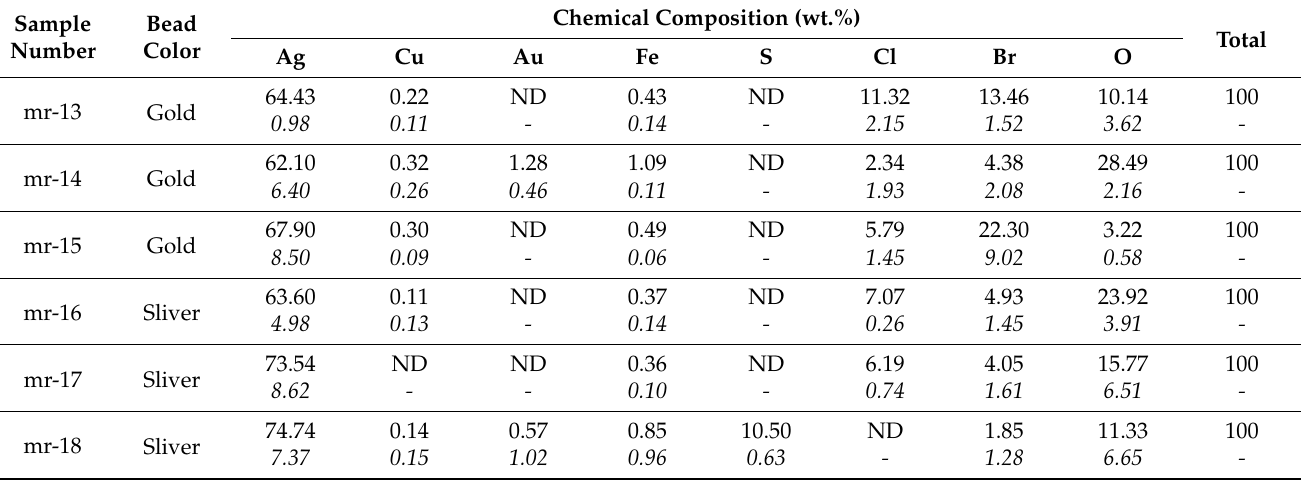
Table 2. SEM-EDS analytical results of metal foil in foil glass beads excavated from the Tomb of King Muryeong in